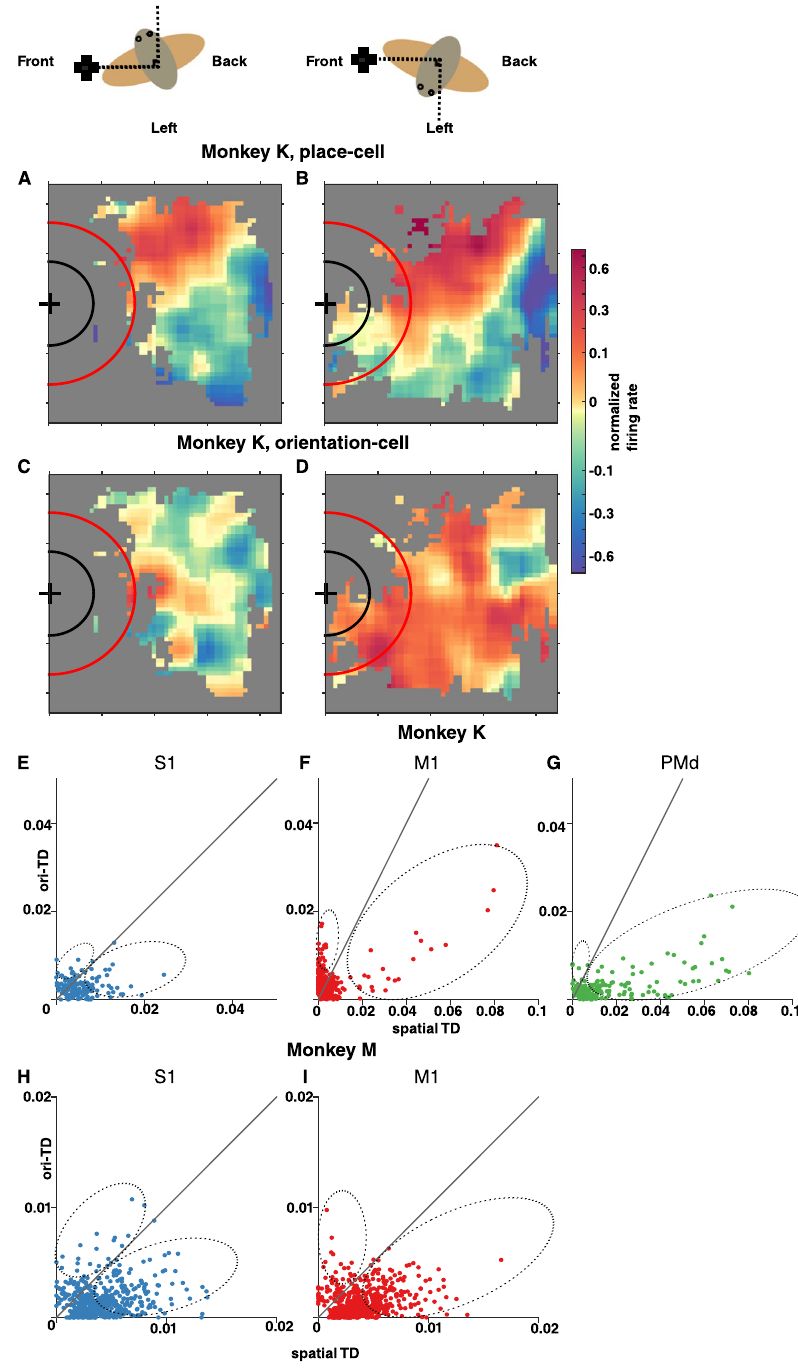
Figure 2. Neuronal tuning to room location and head orientation. ( A – D ) Modulation of spatial tuning patterns by head orientation in two neurons from monkey K. Conventions as in Fig. 1B–G. The color plots correspond (see key on top) to the right from the grape dispenser ( α from 45 to 135 degrees; A , C ) or to the left from the dispenser ( α from − 45 to − 135 degrees; B , D ). The spatial tuning pattern of one PMd neuron did not substantially change with the head orientation ( A , B ), whereas the pattern of another M1 neuron dramatically changed ( C , D ). (E – I) Scatterplots of tuning depth (TD) to room location versus TD to orientation ( α and β ) for monkey K’s ( E–G ) or monkey M’s (H-I) neurons with significant mutual information to either parameter from all sessions, across cortical areas: S1 ( E , H ), M1 ( F , I ) and PMd ( G ). The diagonal lines show where space-TD equals to orientation-TD. The dashed ellipses below and above the diagonal lines illustrate clusters of highly- tuned position-preferring and orientation-preferring neurons,